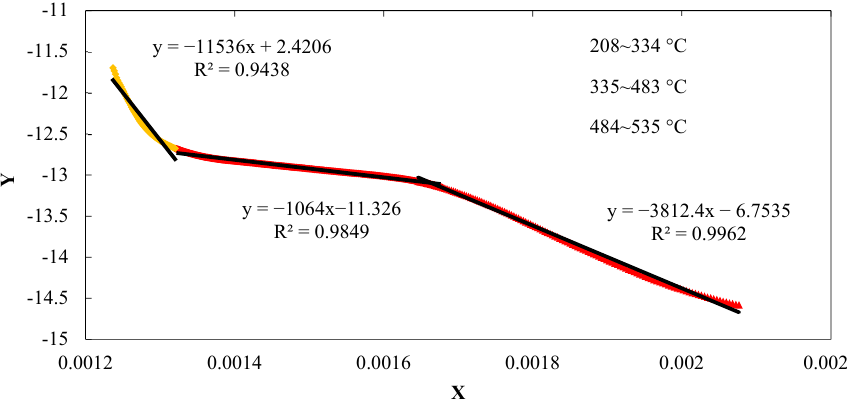
Figure 5. The fitting equation of the chicken manure thermal decomposition subjected to air atmos- phere and 10 °C/min heating rate.